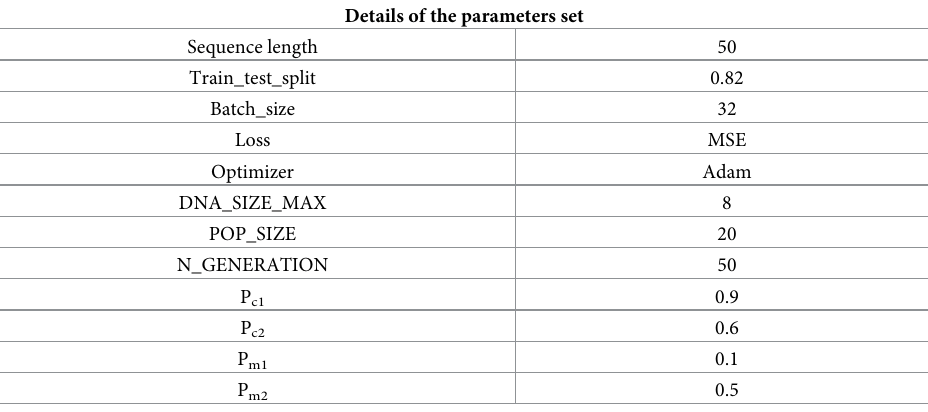
Table 4. Parameters set for adaptive genetic